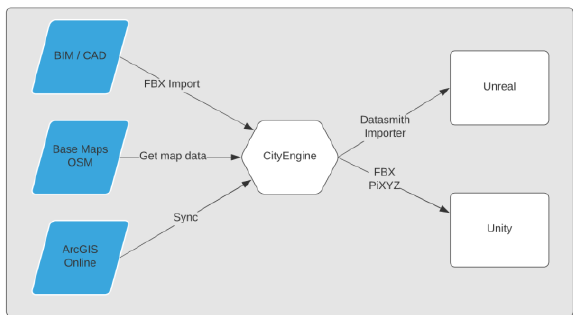
Figure 3 . Scheme of importing GIS data into game engines As with the survey of individual technologies, flowcharts are created here as well. These diagrams show the possibilities of interconnecting technologies. Due to the influence of input data on the possibilities of processing and interconnection of technologies, several versions of these diagrams will be created, which will represent different input data (size, type, format, etc.).